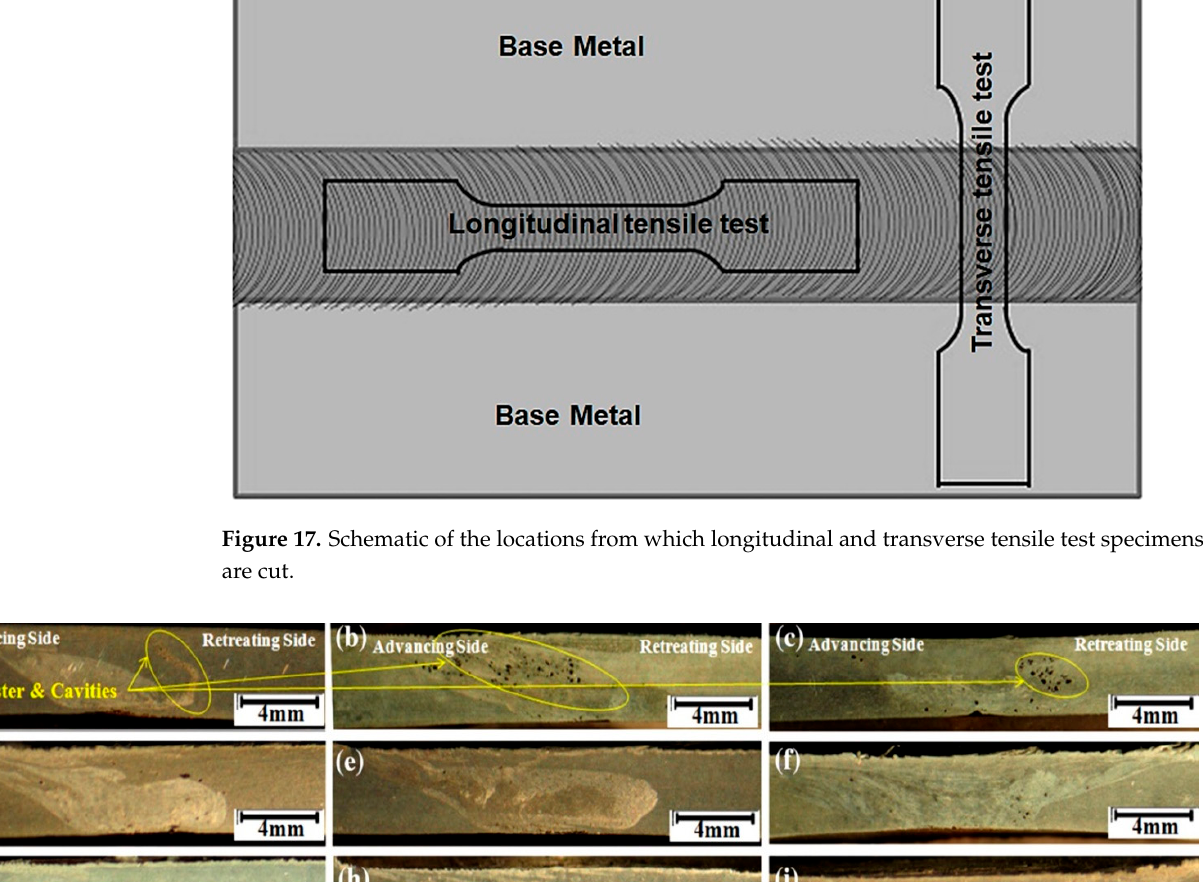
Figure 17. Schematic of the locations from which longitudinal and transverse tensile test specimens are cut.